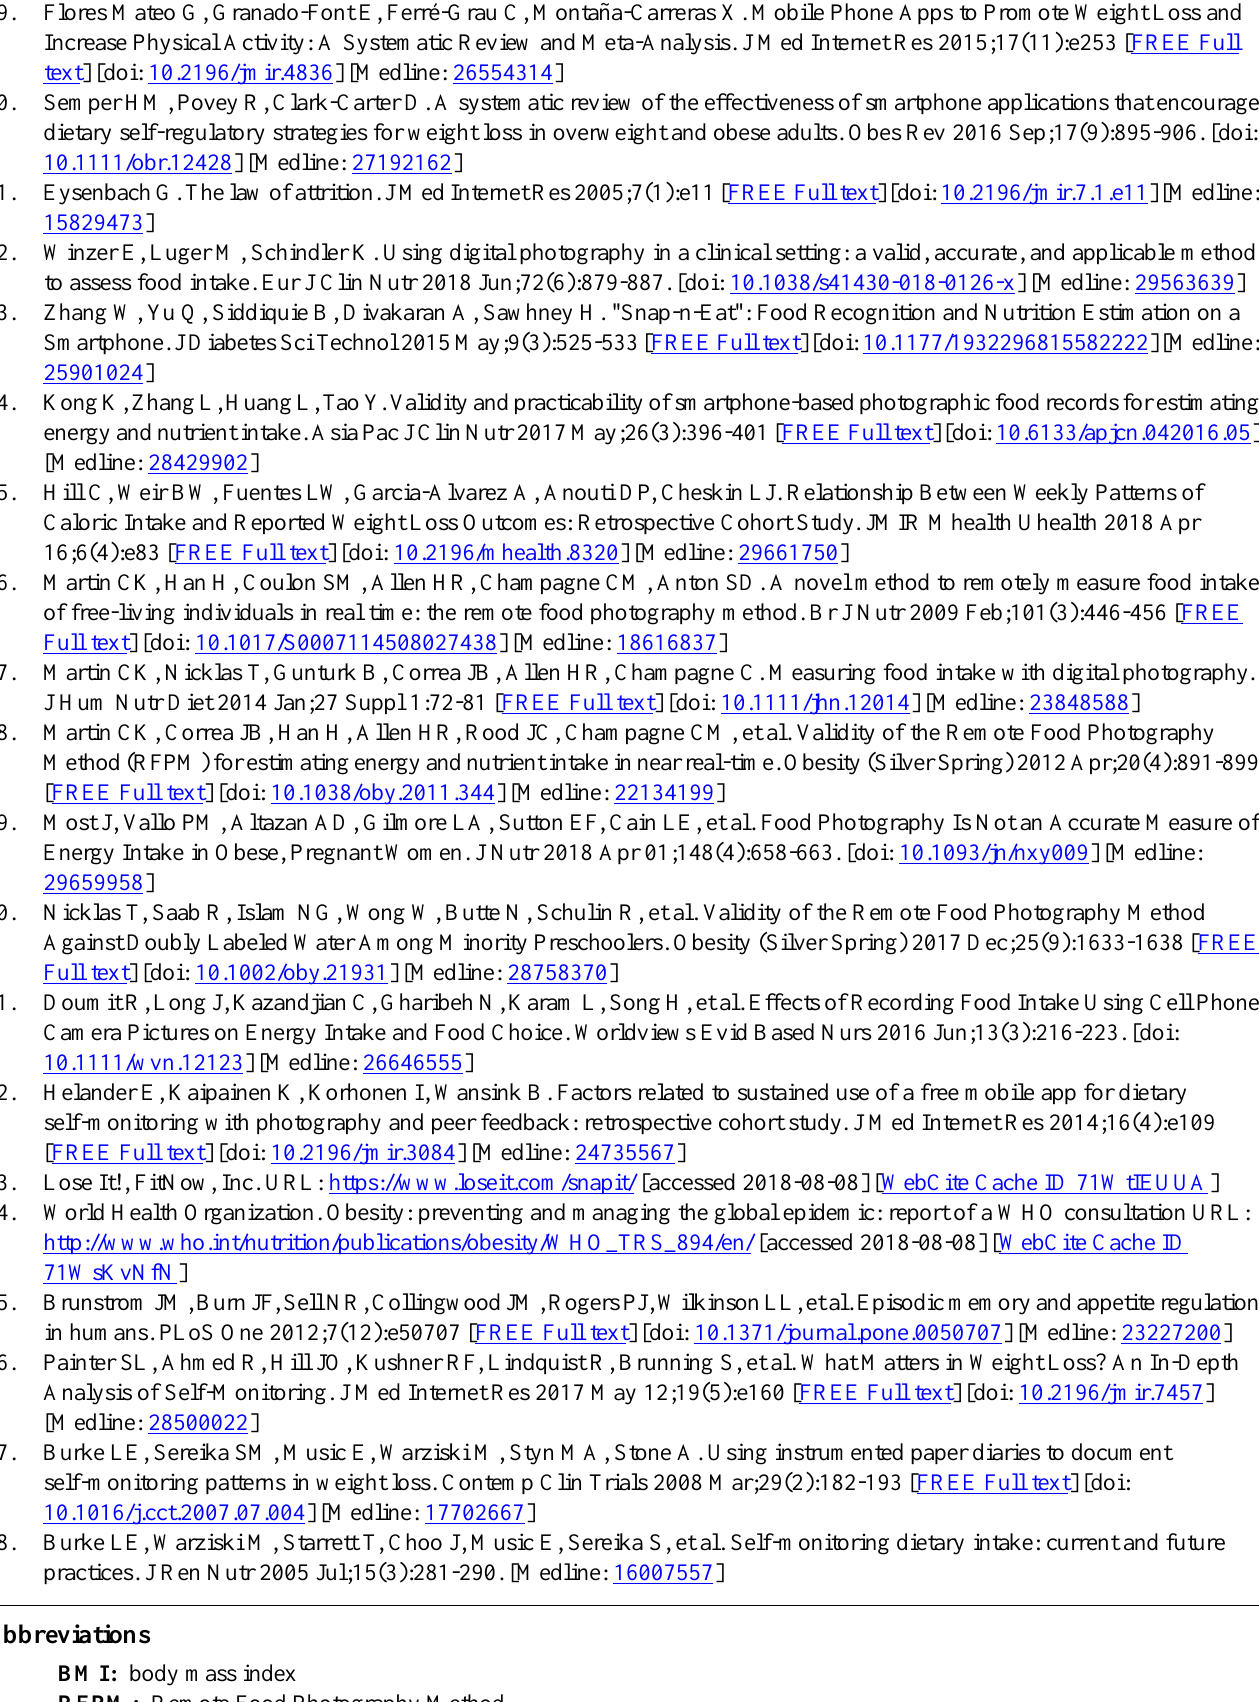
Abbreviations BMI: body mass index RFPM: Remote Food Photography